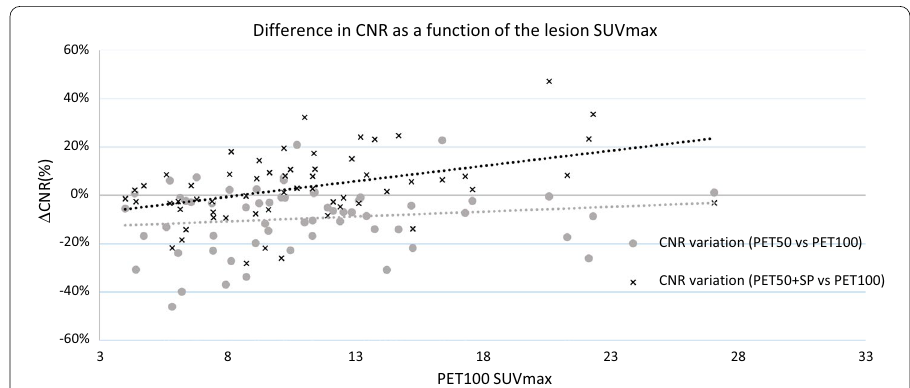
Fig. 9 Scatter plot of the variation of Contrast to Noise Ratio between the PET100 and the PET50 images, as a function of the PET100 SUV max , for the 60 lesions selected by the physicians. The CNR restoration is less dependent to lesion SUV max with